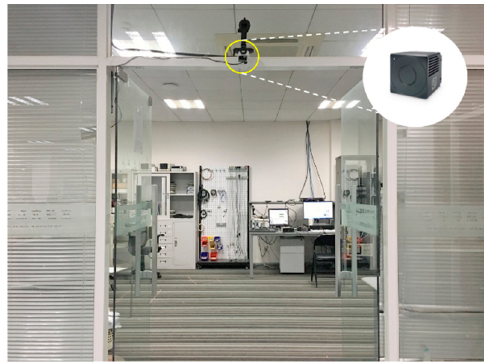
Figure 8. The experimental environment and installation of TOF camera in the laboratory scene.